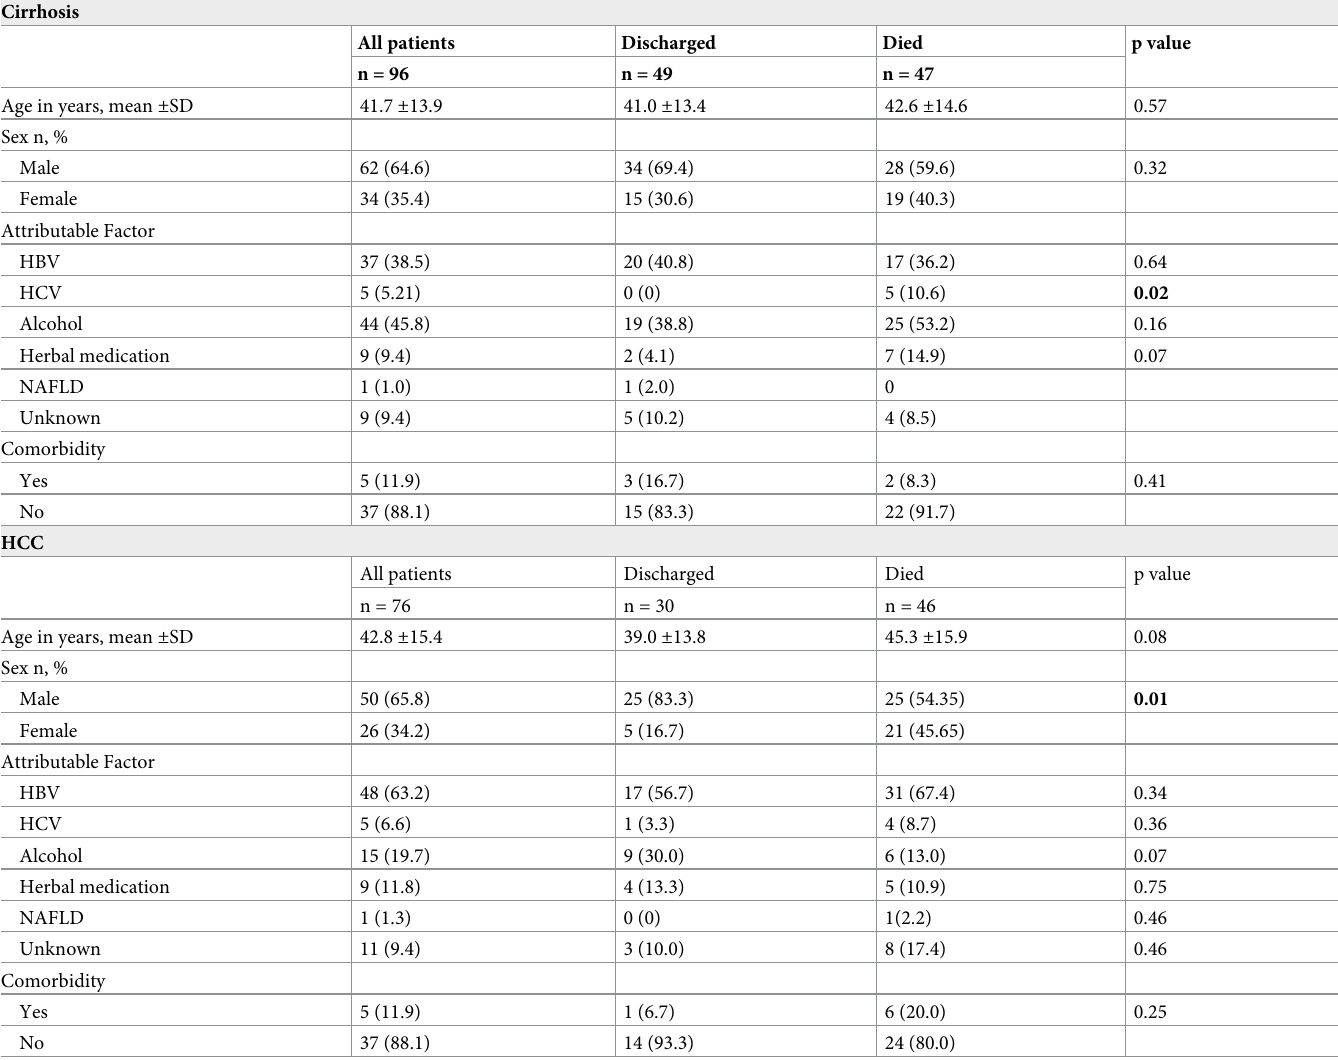
Table 3. Baseline characteristics of patients discharged vs. patients who died on admission by